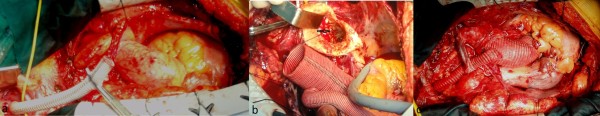
Intra-operative images demonstrating our technique of open surgical repair. (a) Arterial cannulation introduced into the right common carotid artery via an interposed 8mm Dacron graft (b) Identification of Kommerell’s diverticulum and the origin of the right subclavian from within the aortic arch (c) The distal right subclavian artery (RSA) anastomosed to the side branch (10 mm) of the ascending aortic Dacron graft.